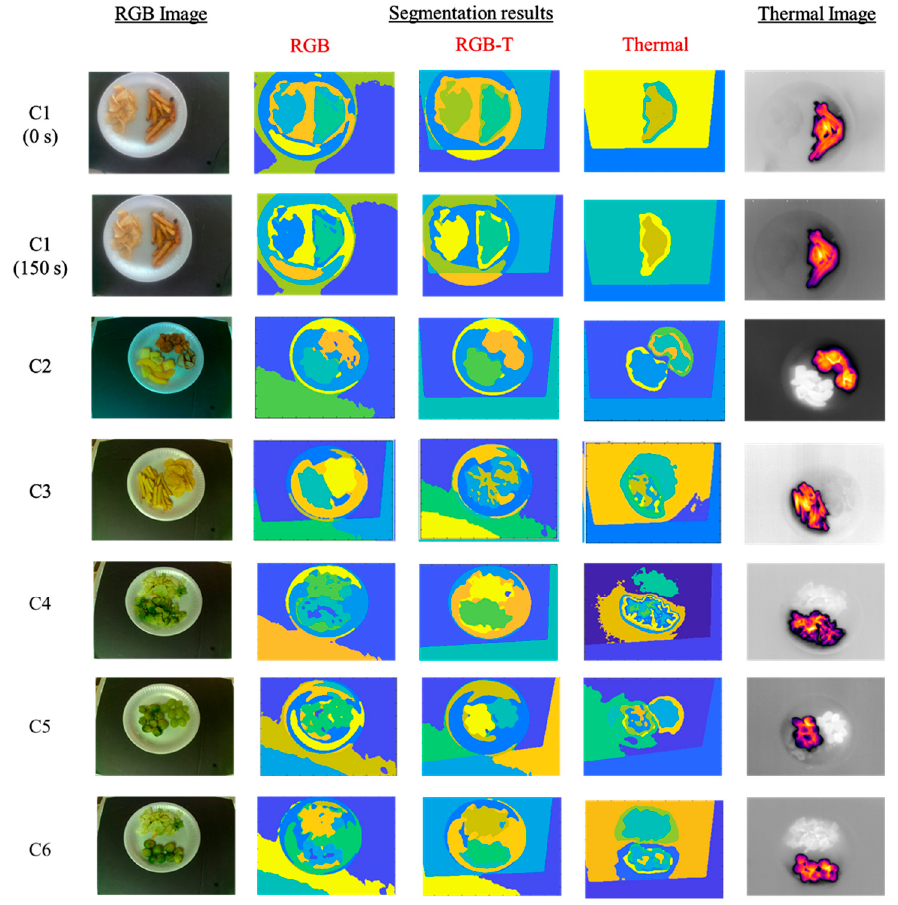
Figure 4. Segmentation results of the six combinations using RGB, thermal and RGB-T data. Table 2. Segmentation Results (Combinations C1–C6): F1 Score.